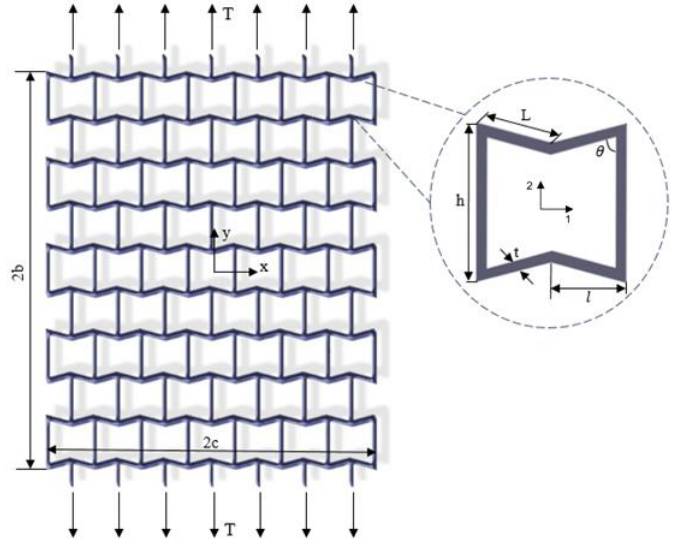
Figure 1. Re-entrant lattice structure is made of hexgonal unit cells whose geometrical parameters are shown in the subfigure. The lattice structure is supposed to be under uniaxial tensile loading.